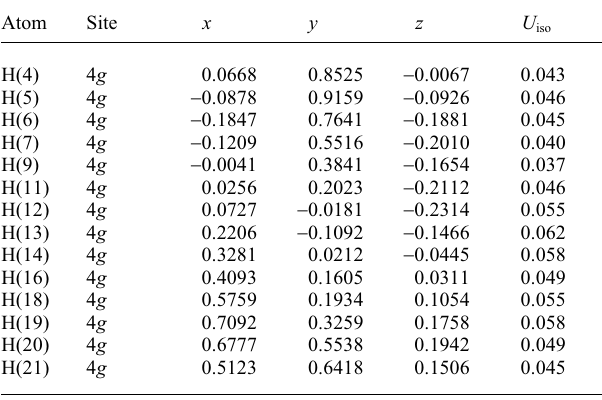
Table 2. Atomic coordinates and displacement parameters (in Å 2 )